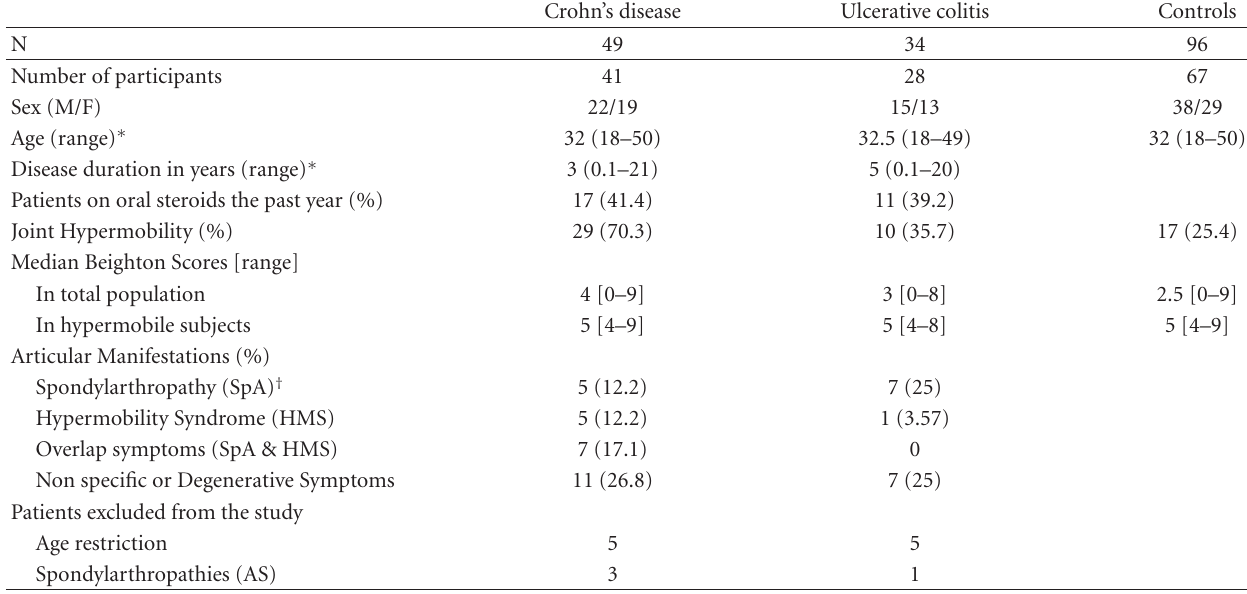
Table 3: Demographic and clinical data of IBD patients and